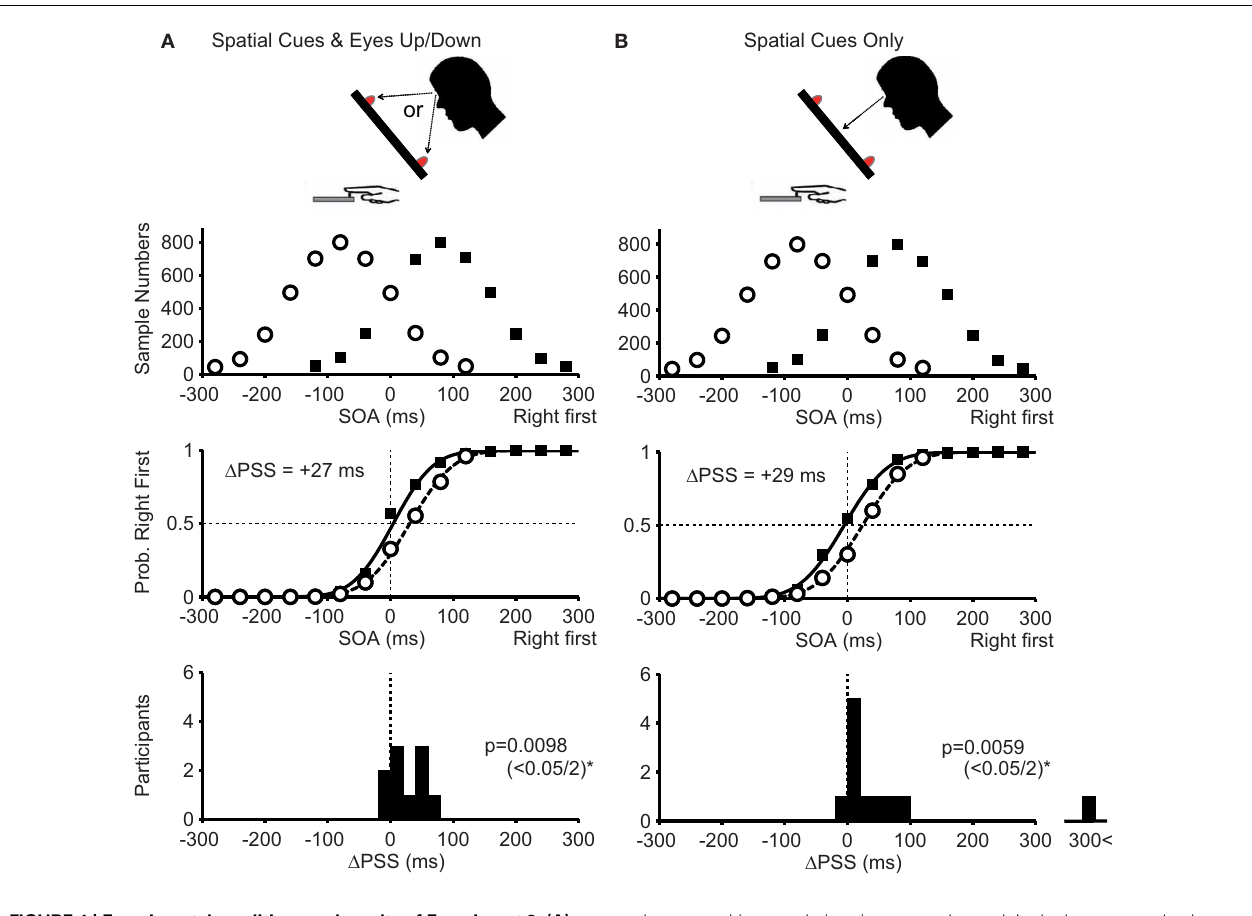
FIGURE 4 | Experimental conditions and results of Experiment 2. (A) : With spatial cues and eye movements (condition 1). (B) :With spatial cues without eye movements (condition 2). In condition 1, the participants’ eye positions changed, but the cue positions on their retinas were constant. Conversely, in condition 2, the participants’ eye positions were constant, but